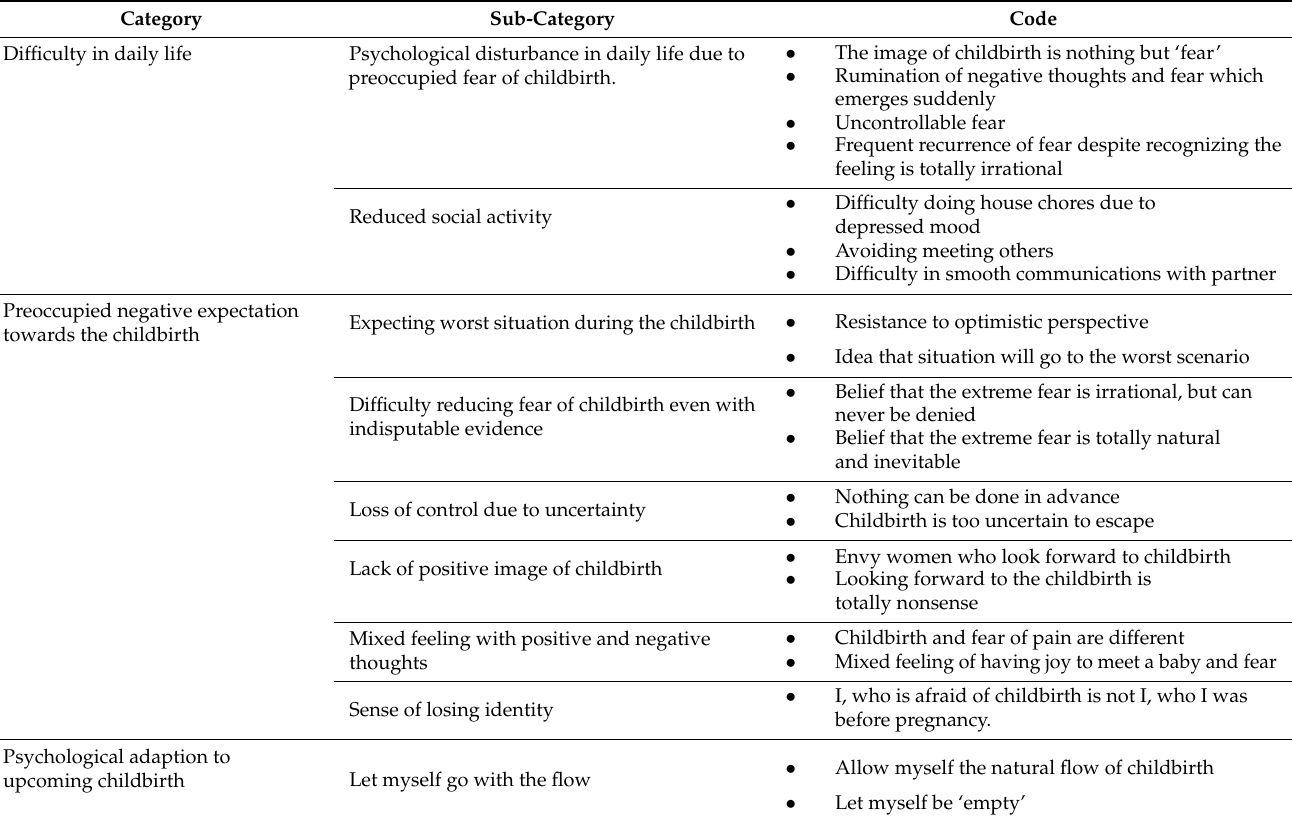
Table 3. Experience of severe fear of